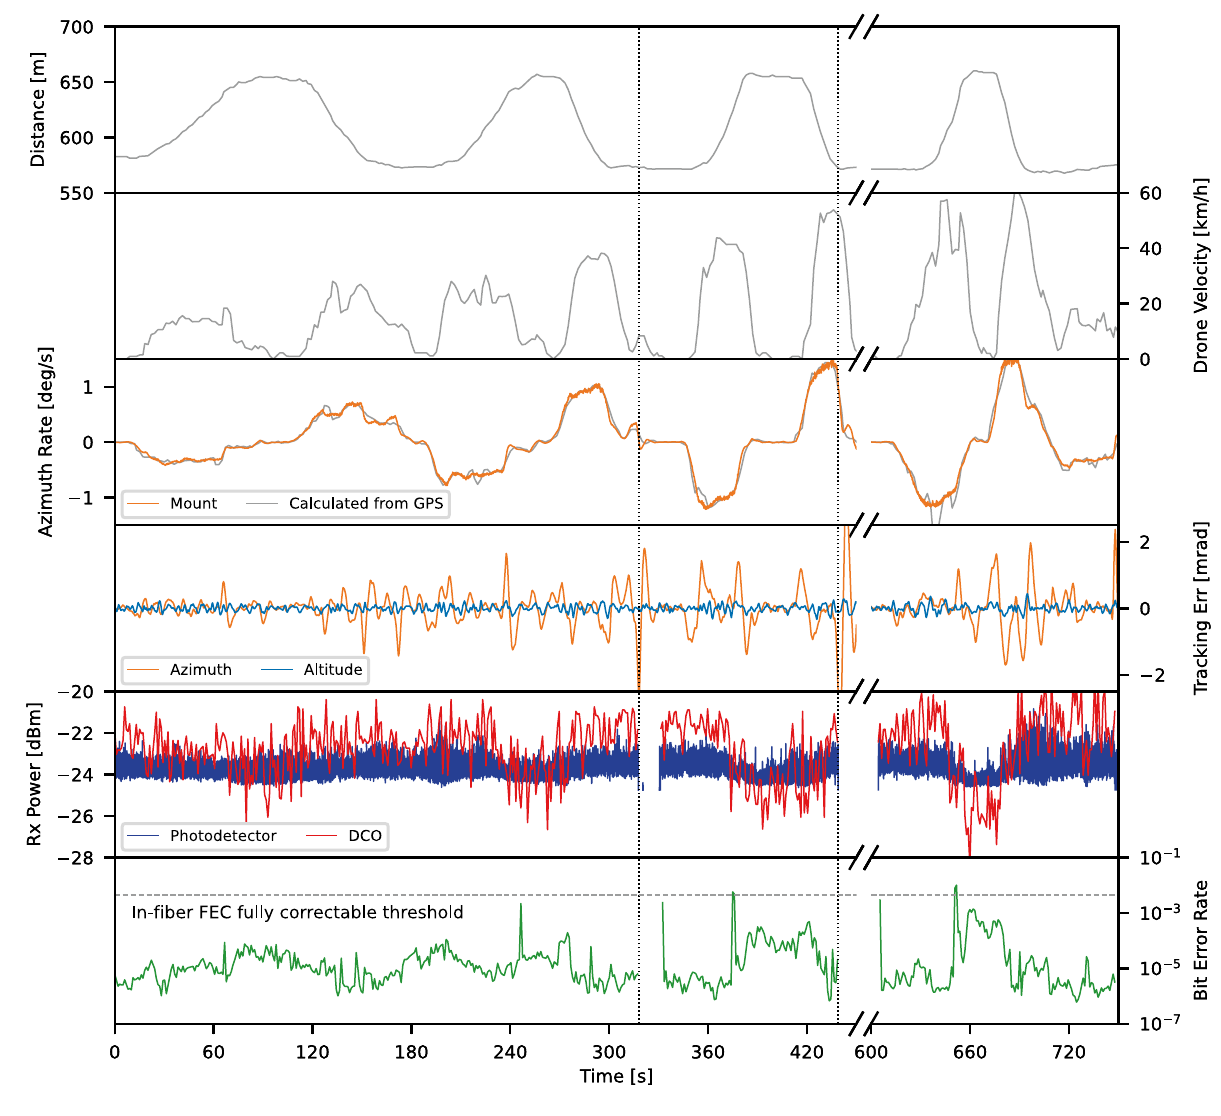
Figure 9. Time series data. From top to bottom: line-of-sight distance between the deployable optical terminal and drone as calculated from GPS. Drone horizontal velocity, as calculated from GPS. Mount azimuth tracking rate, as calculated from mount (orange) and GPS (grey). Machine vision tracking errors in azimuth (orange) and altitude (blue). Received optical power from photodetector (blue) and DCO module (red). BER. Times of link dropout are delineated with a dotted line ( t = 318 s and t = 439